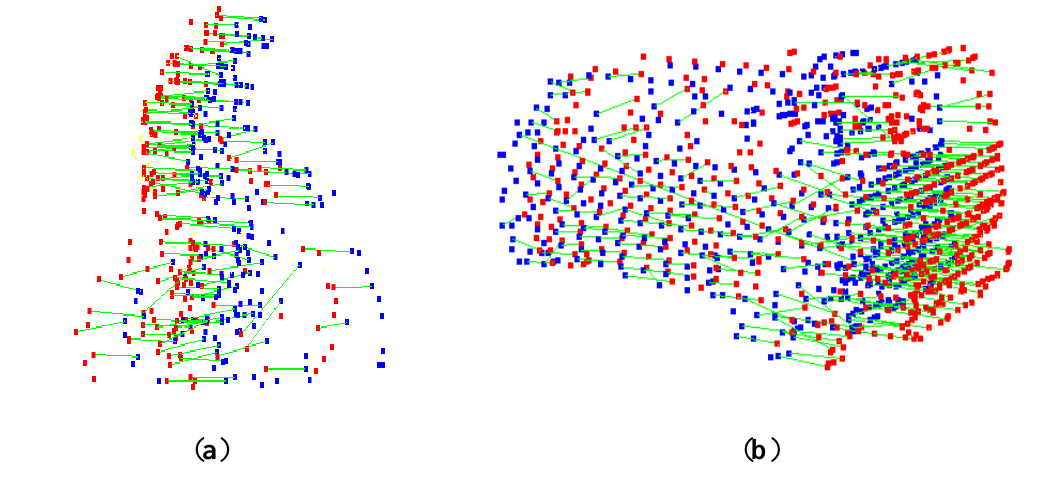
Figure 5. Feature matching: ( a ) A cyclist; ( b ) a car at two consecutive epochs (red and blue). Green lines represent the matched